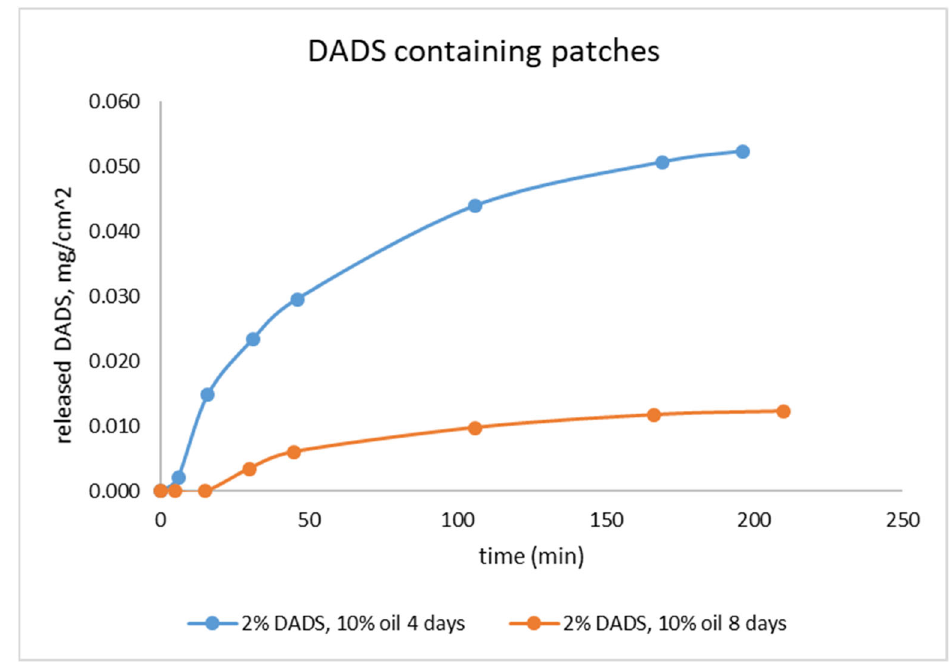
Figure 4. The cumulative release rate of the samples in the Franz cell.